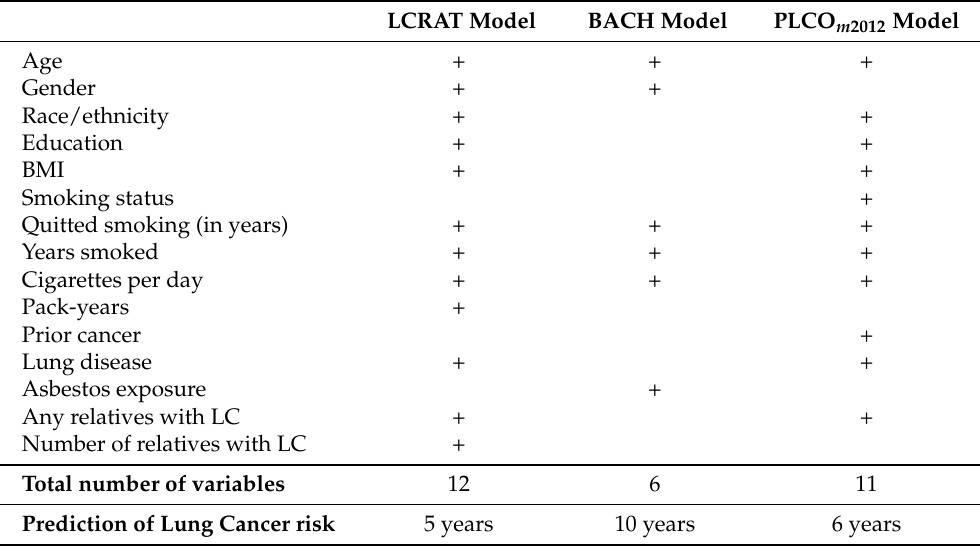
Table 1. Summary of variables used in the LCRAT, BACH, and PLCO m 2012 models. The plus sign means that the variable is included in the model. LCRAT Model BACH Model